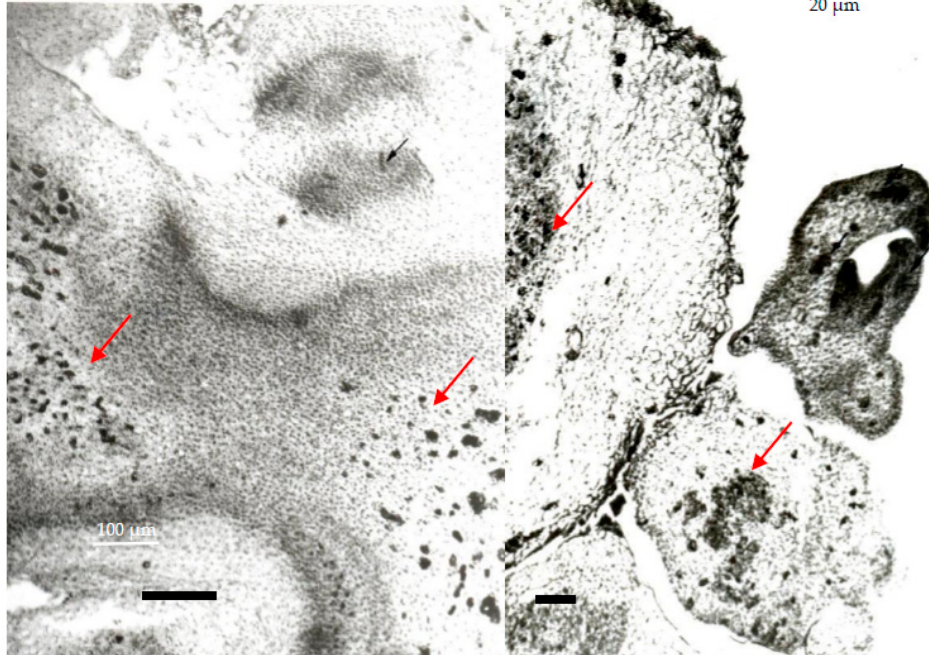
Figure 2. Histological analysis of slide images taken for S. podophyllum callus obtained in the MS62 culture medium. This was a full organogenetic callus producing roots and shoots. Nodular-like structures where organogenesis is taking place can be observed (in the tips of the right-hand shoot formation and in a transversal section of the upper part of the left-hand shoot formation; black arrows). Xylematic-like elements or bundles can be observed in the vicinity of all organogenetic centers (see red arrows; magnification × 270 (left) and × 135 (right); bars = 100 µ m). By changing the basic mineral formula, e.g., for the N69 mineral composition, the harder greener callus revealed the formation of well-developed XTEs during the histological study (see Figures 3 and 4). By analyzing different histological images taken at the time, we further observed that these XTEs were constantly arranged in areas positioned at the bases of meristematic domes, as well as those of developing leaves or shoots. Small XLSs could also be observed close to areas comprising polarized nodular-like shapes recognized for their relevance in the initiation of